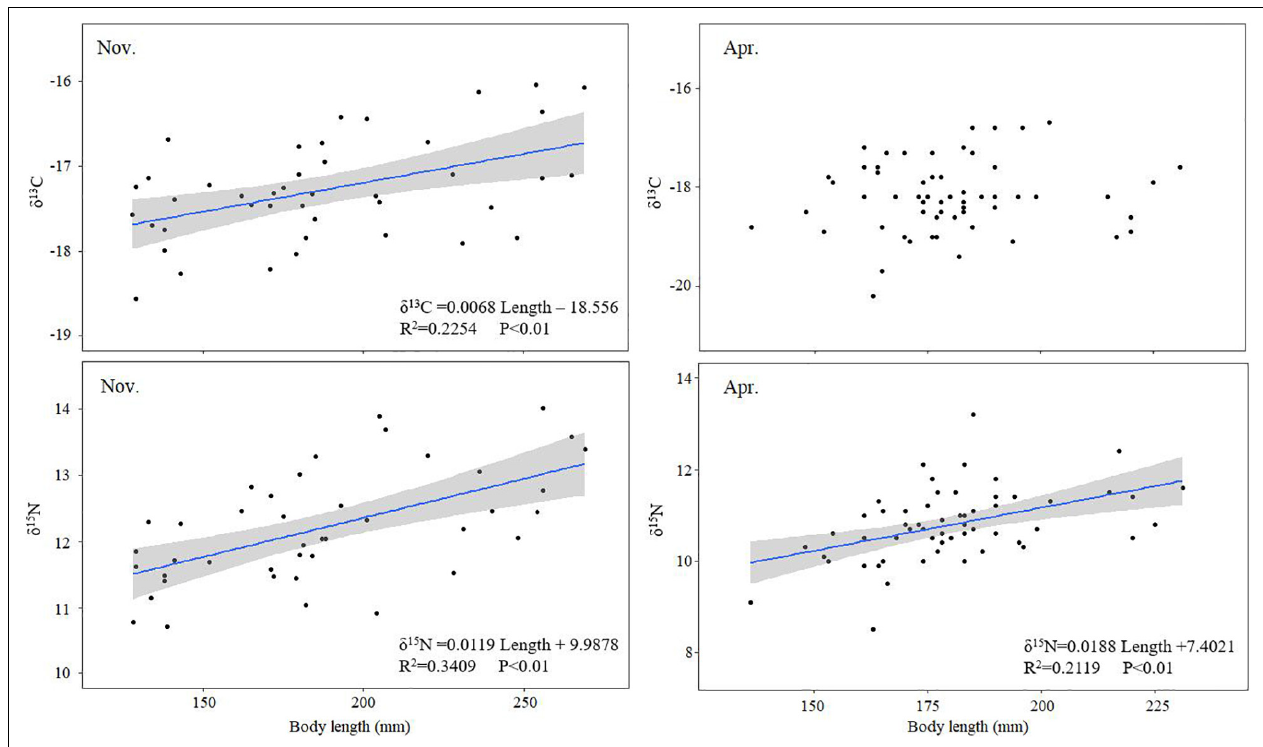
FIGURE 4 | The relationships between the stable isotope signatures ( δ 13 C and δ 15 N) and body length of Bombay duck in November (left) and April (right). The shaded areas represent 95% confidence intervals and regressions are only shown when